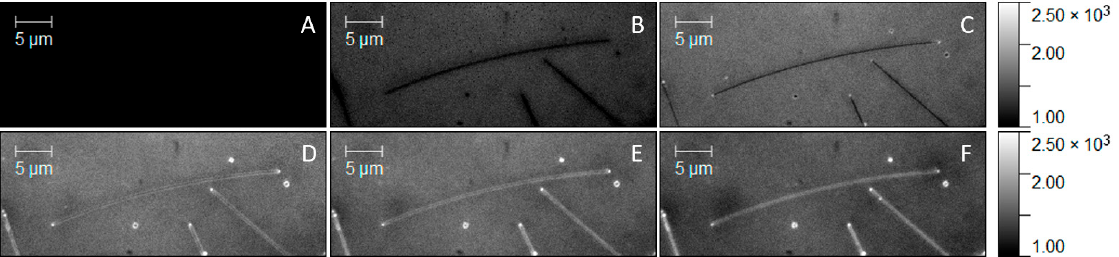
Figure 6. Fluorescence intensity maps of mCherry solution ( A ) before deposition and ( B ) at the time of deposition. ( C – F ) Protein conjugation process over